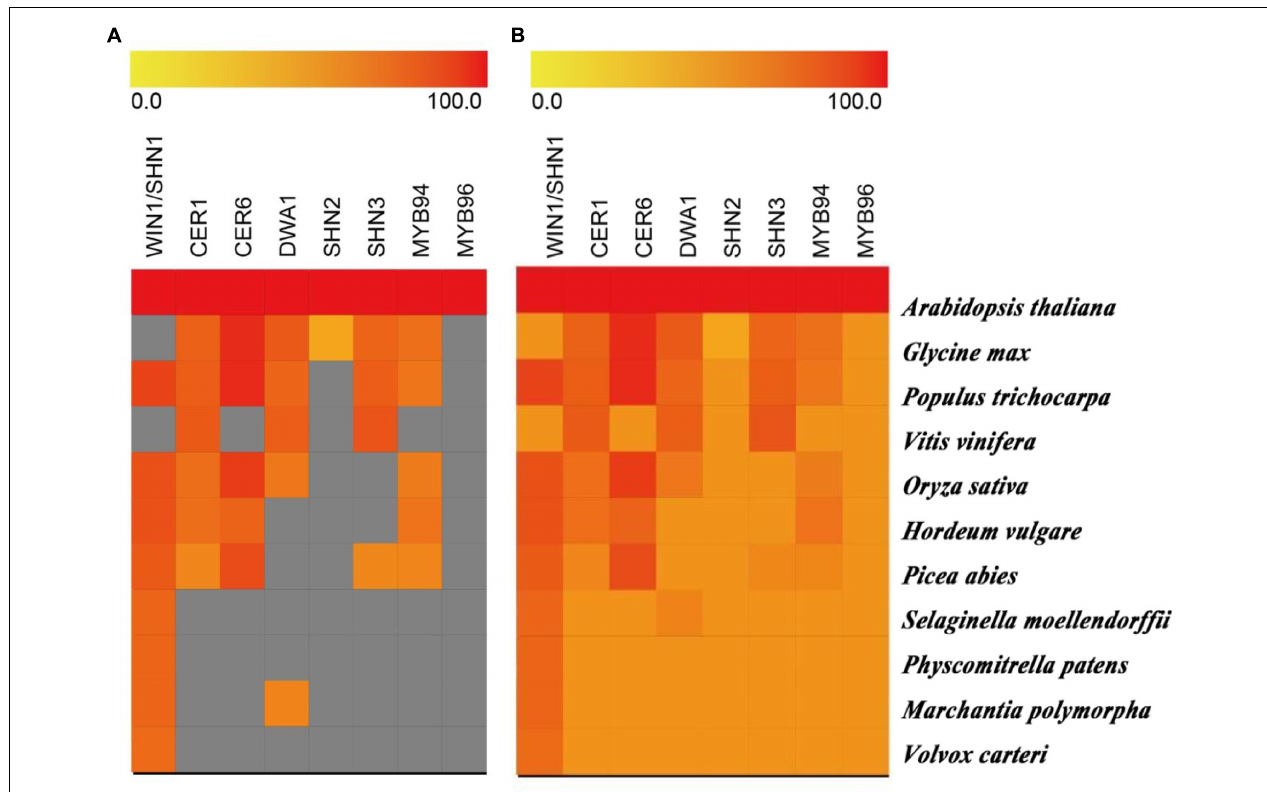
FIGURE 2 | Similarity heat map of key cuticular wax-related genes involved in drought tolerance in different species. Genesis software was used to estimate the similarity among selected protein sequences of different plant and algal species. Candidate protein sequences were selected by BLASTP searches which satisfied E-value < 10 − 10 and query coverage > 50% (A) and an E-value < 10 − 5 (B) . Colored squares indicate protein sequence similarity from zero (yellow) to 100 (red). Gray squares indicate proteins that are satisfied with the selection